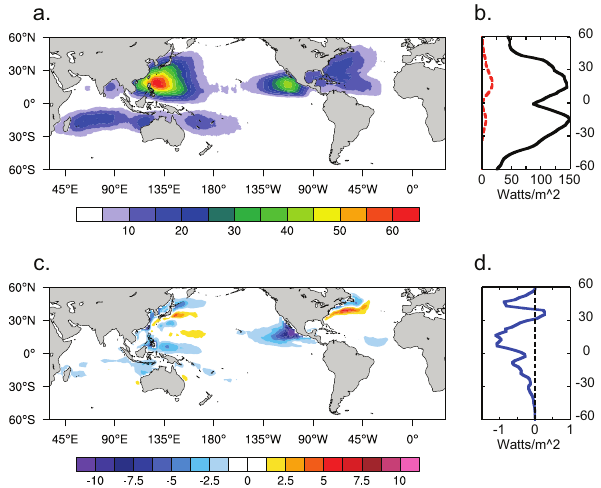
Figure 6. Geographical pattern of air–sea heat flux caused by TCs. (a) Globally integrated heat flux caused by TCs calcu- lated using Argo float data (Wm − 2 ) . (b) Zonally averaged TC- induced heat flux (red curve), compared with the annual climatol- ogy (1990–2010) of air–sea latent heat flux (black curve) derived from NCEP/NCAR reanalysis (Kalnay et al., 1996). (c) Surface flux (positive upward) along storm tracks for climatological conditions during the period 1990–2010 (Wm − 2 ) , derived from NCEP/NCAR reanalysis using storm tracks from 1990 to 2010. The plot represents the background air–sea flux contribution to the Argo analysis using the 20-year daily climatology. (d) Zonal average of the climatolog- ical net surface heat fluxes shown in (c)